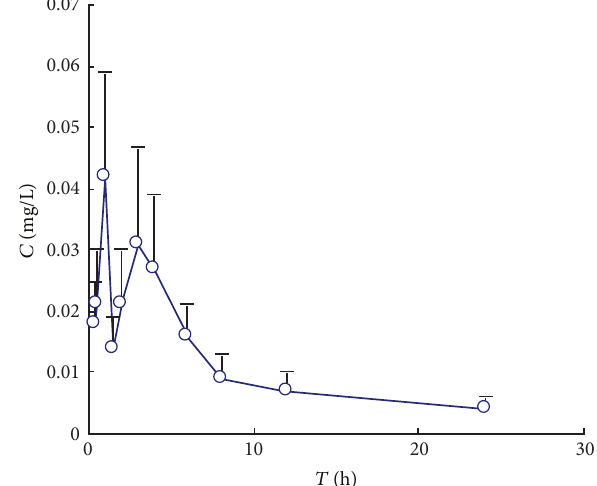
Figure 4: Mean plasma concentration-time curve of (4 E ,6 E ,12 E )- tetradecatriene-8,10-diyne-1,3-diyl diacetate after oral administra- tion of processed Atractylodis Rhizoma (40g ⋅ kg −1 ) to rats. (mean ± SD, 𝑛 = 6